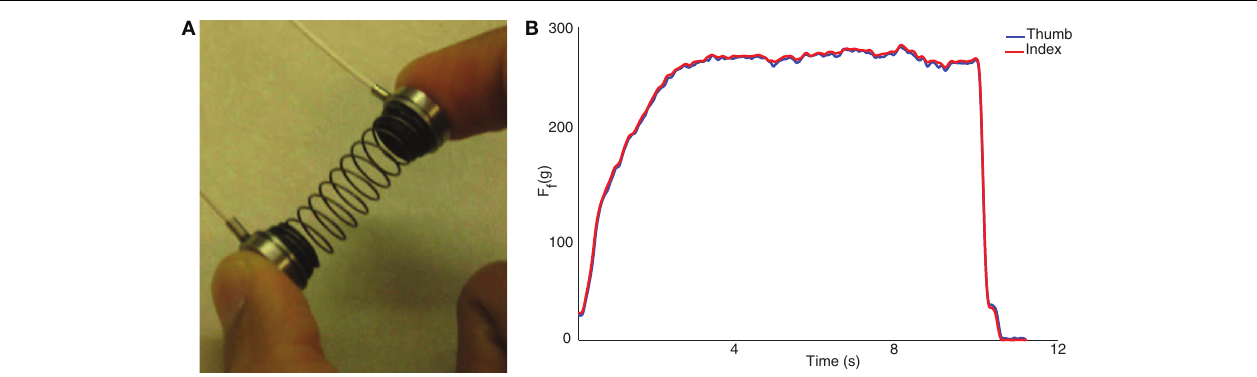
miniature load cells. Sample data from spring compression are shown to the right (B) .The forces from the thumb and index finger, in gf, are averaged to calculate the maximal compression force.